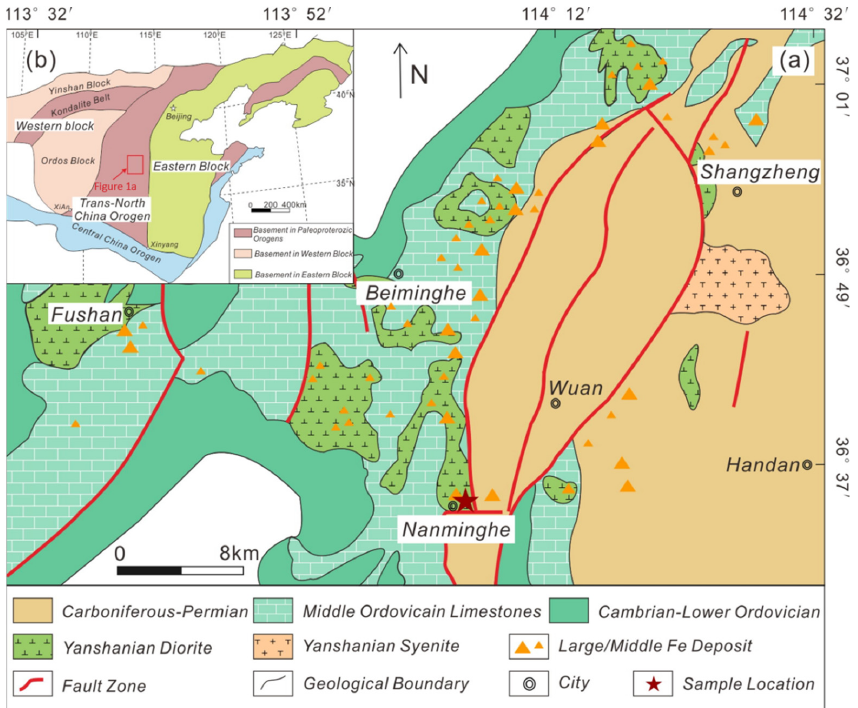
Figure 1. ( a ) Geologic map of Wuan district (modified from [14]); ( b ) Major tectonic units of the North China Craton (modified from [21]).